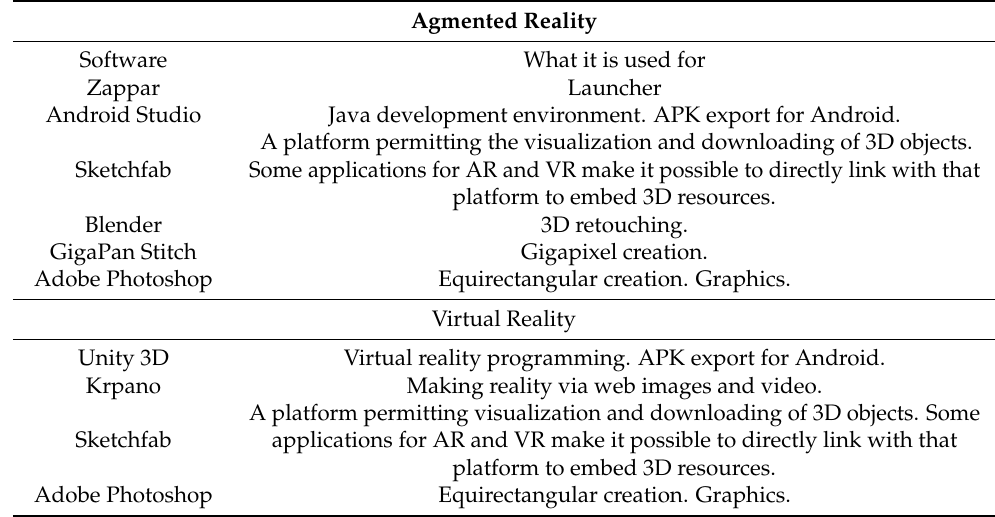
Table 1. Software used for the production of AR and VR objects. Source: elaborated by the